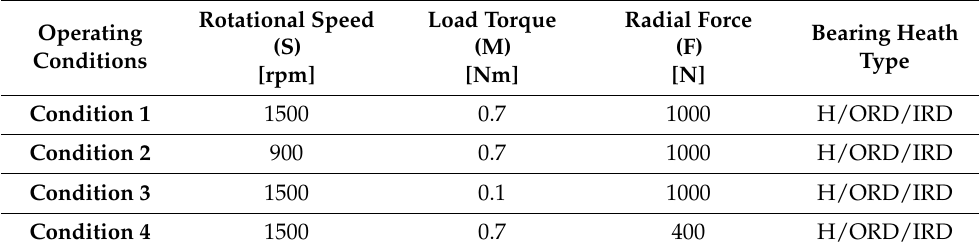
Table 3. Details of the four different operating conditions of rolling element bearings.